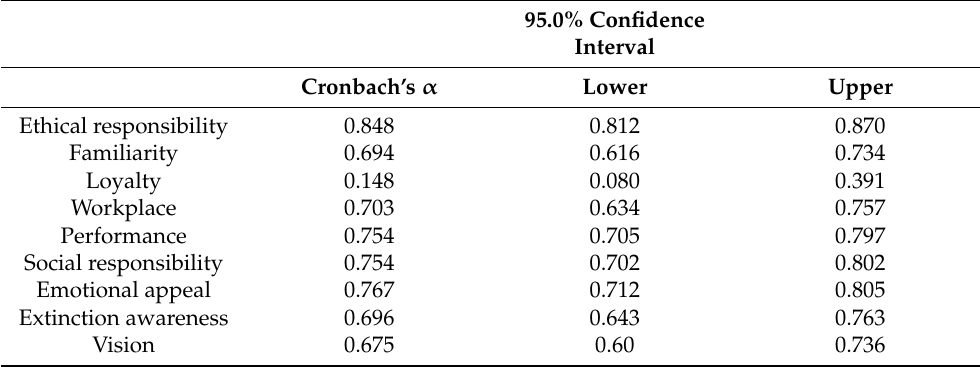
Table 2. Reliability Scale of ZERS drivers. Crombach’s α CI values ranging from 0.70 to 0.85 are considered